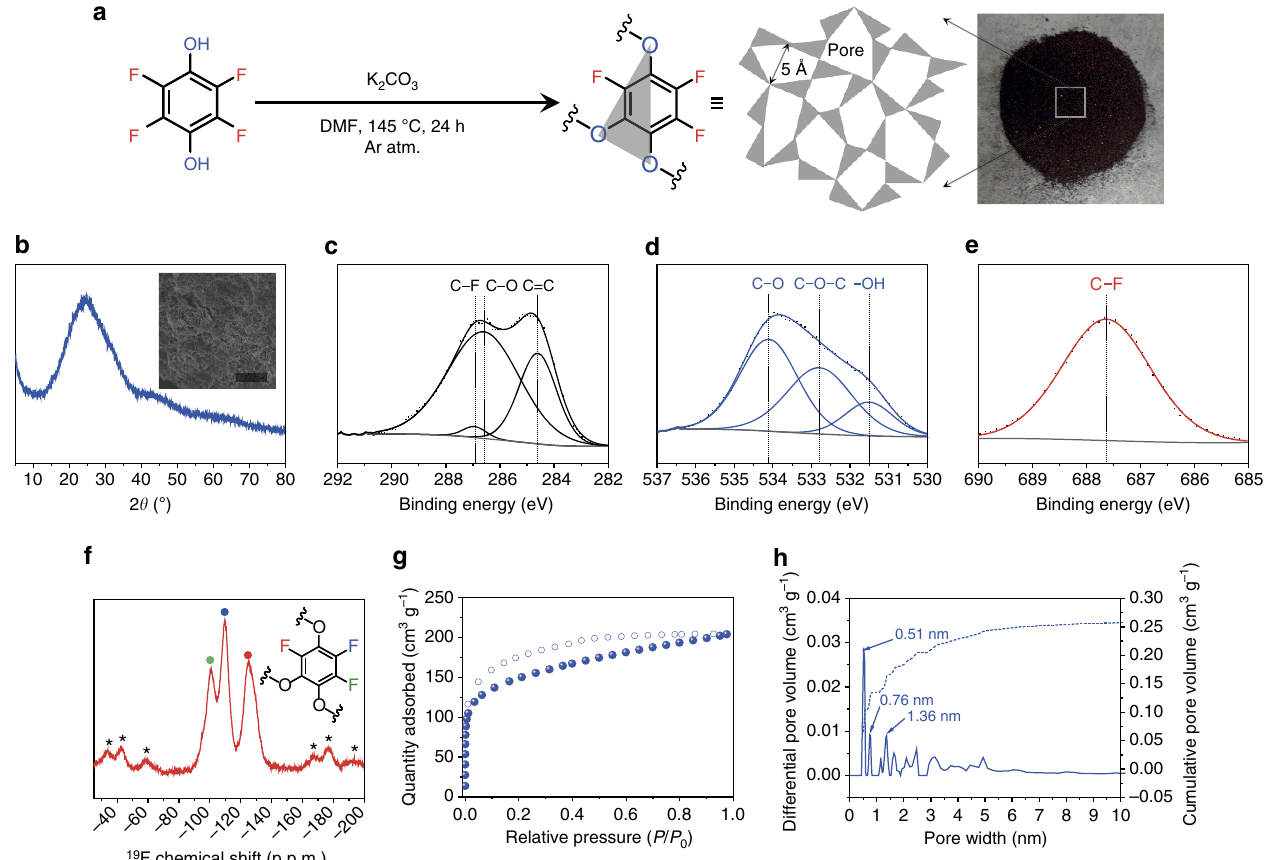
Figure 1 | Synthesis and characterization of COP-99. ( a ) Proposed chemical structure of COP-99 along with its synthetic procedure. The obtained polymer was dark brown powder. ( b ) Powder X-ray diffraction pattern of COP-99. Inset displays scanning electron microscopy image of COP-99. Scale bar, 10 m m. ( c ) C 1s, ( d ) O 1s, and ( e ) F 1s XPS spectra of COP-99. ( f ) Solid-state 19 F-NMR spectrum of COP-99. Black asterisks (*) indicate spinning side